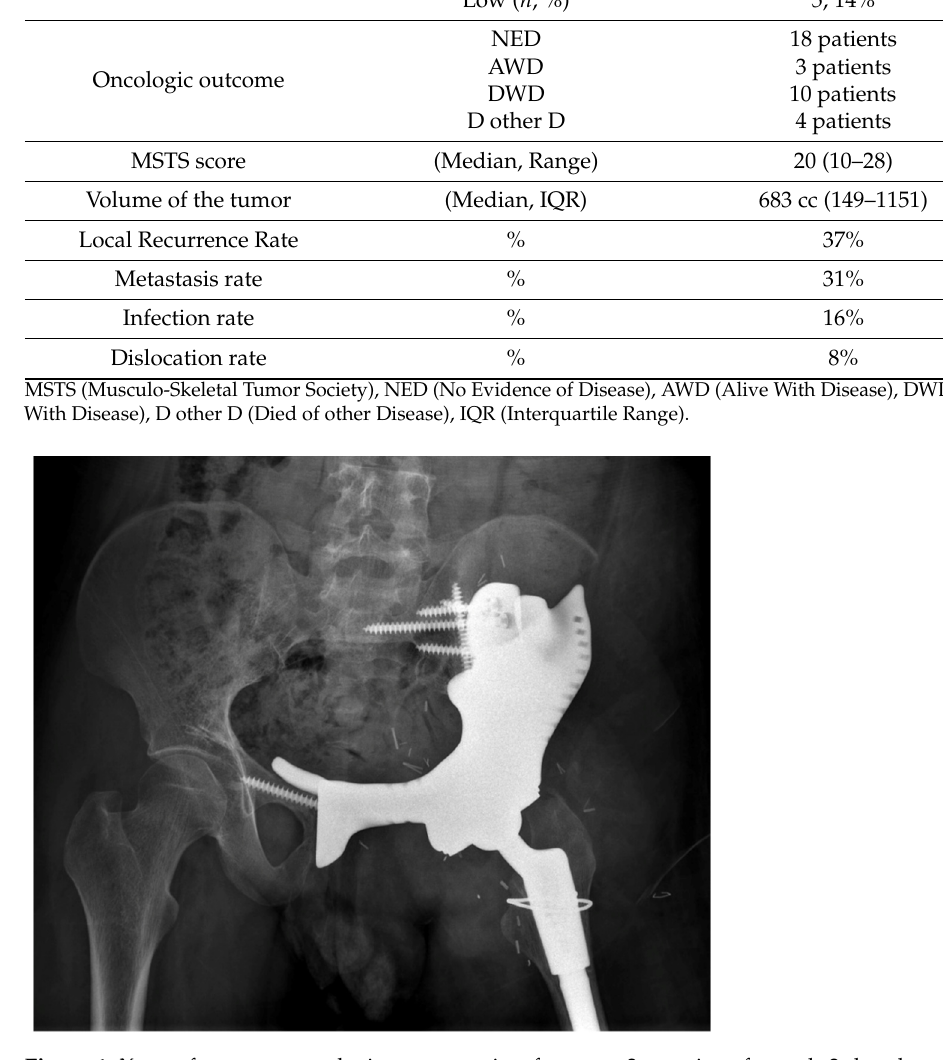
Figure 1. X-ray of a custom prosthetic reconstruction, for a type 2 resection of a grade 2 chondrosar-